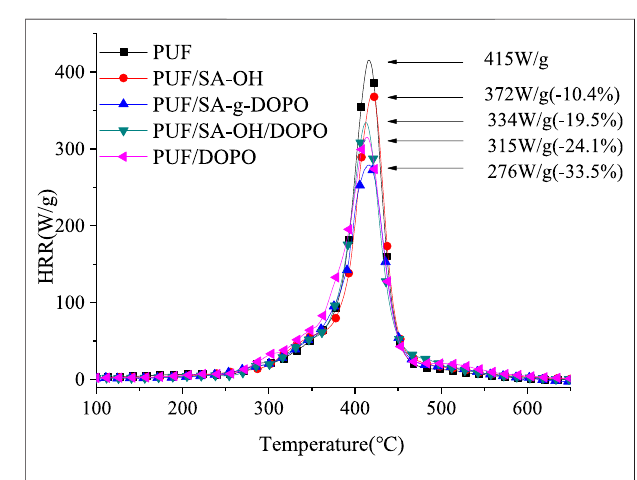
FIGURE 8 | MCC curves for PUF